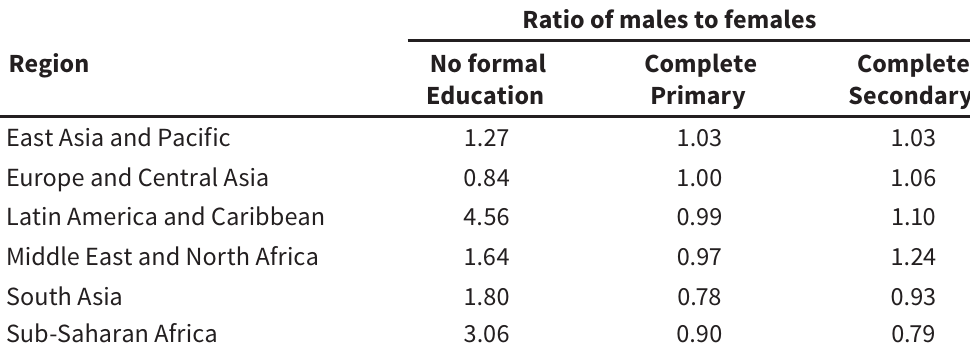
Ratio of males to females